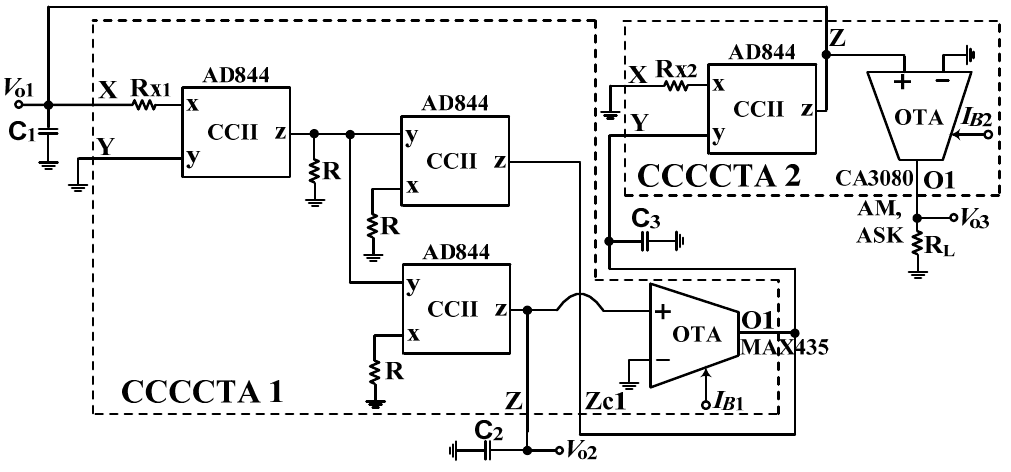
Figure 12. A possible implement method of the proposed oscillator by using commercially available ICs. Appl. Sci. 2016 , 6 , 179